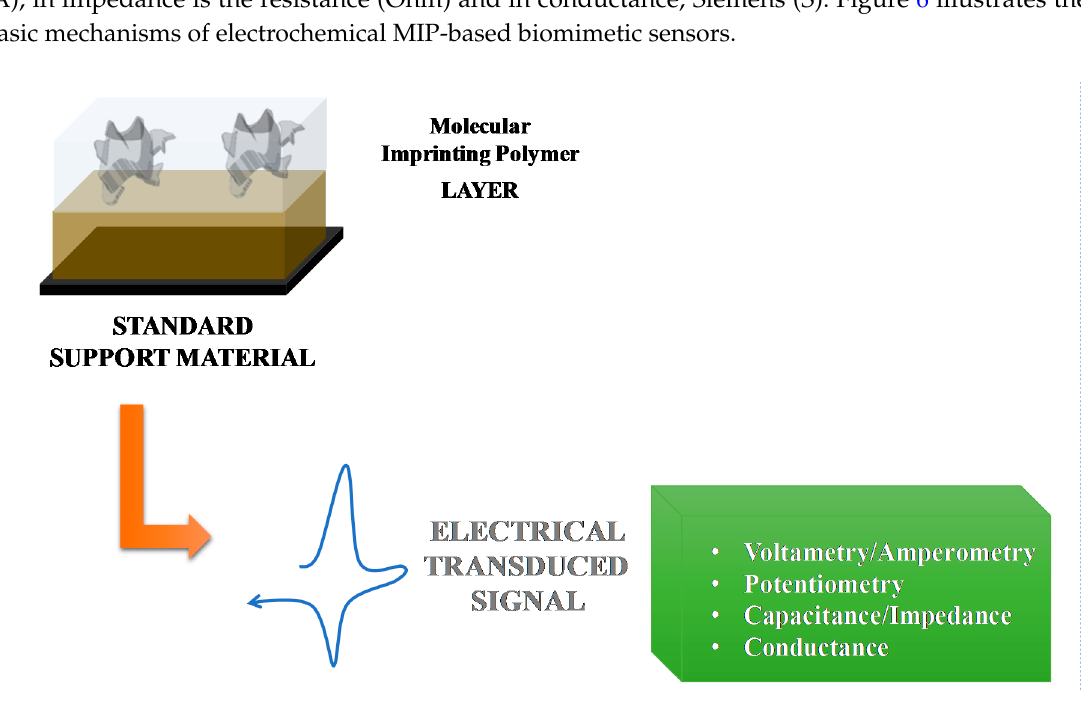
Figure 6. Basic mechanisms of electrochemical MIP-based biomimetic sensors.